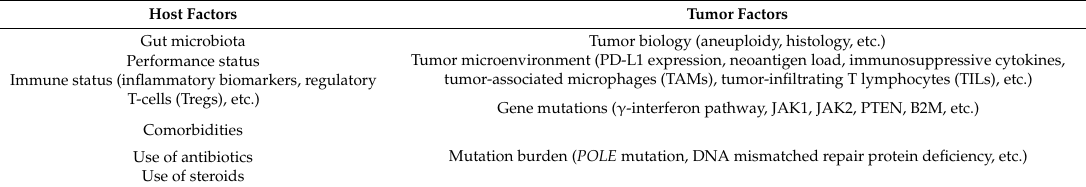
Table 1. Factors associated with primary and secondary resistance to immune checkpoint inhibitors (ICPis). Host Factors Tumor Factors Gut microbiota Tumor biology (aneuploidy, histology, etc.) Performance status Tumor microenvironment (PD-L1 expression, neoantigen load, immunosuppressive cytokines, tumor-associated microphages (TAMs), tumor-infiltrating T lymphocytes (TILs), etc.)Immune status (inflammatory biomarkers, regulatory T-cells (Tregs),